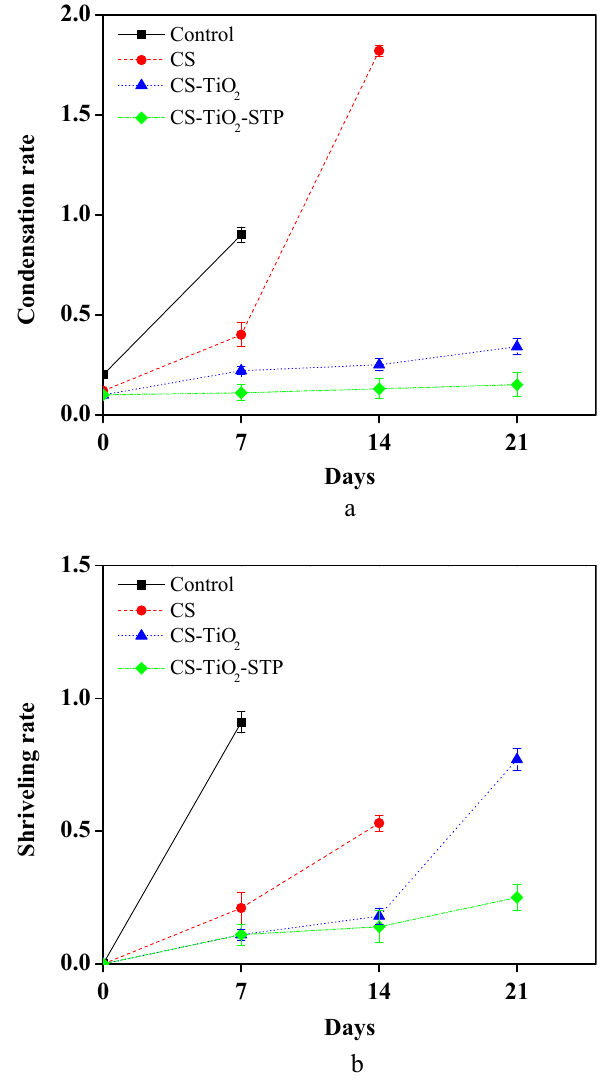
Figure 2. Effect of coating treatments of cucumber samples on condensation ( a ), and shriveling rates ( b ); (Control) refers to the treatment with distilled water, CS is the (Chitosan), CS-TiO 2 is Chitosan/ Titanium Dioxide Nanoparticles, while CS-TiO 2 -STP is (Chitosan/Titanium Dioxide Nanoparticles/Sodium